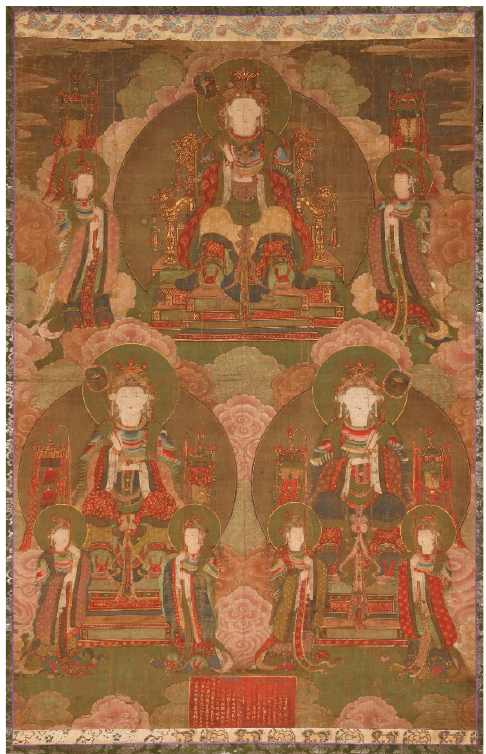
Figure 4. Jeseokjeon Triad , Joseon dynasty (1483), Eiheiji 永平寺 Temple, Japan (Photo by Jeong Utaek).